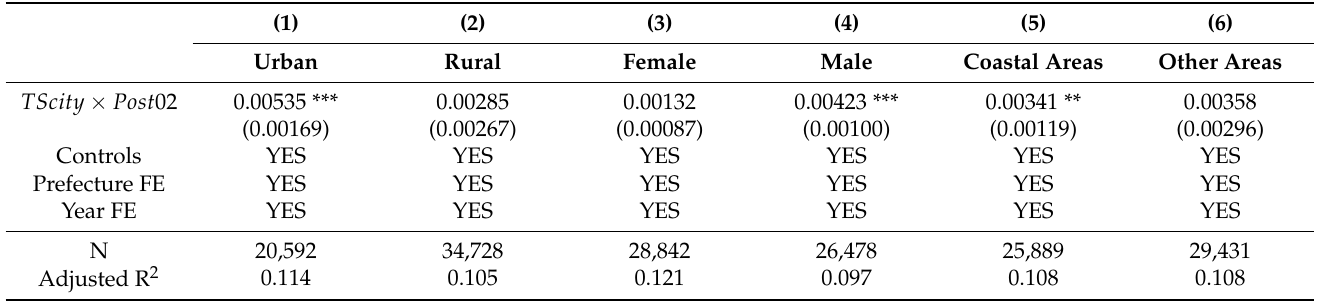
Table 5. Heterogeneity test